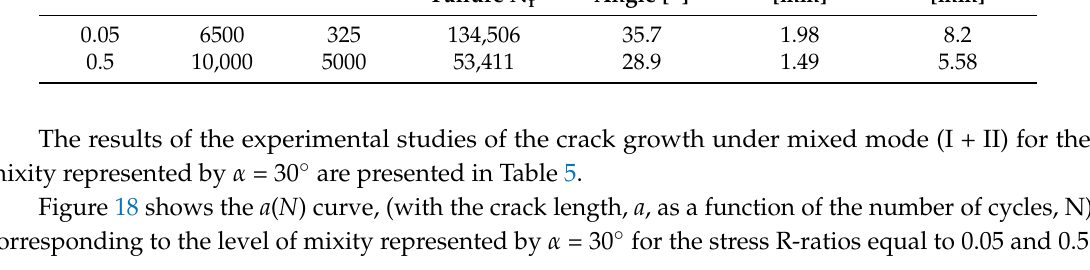
Table 5. Summary of data obtained under mixed mode loading for crack angle of α = 30 ◦ .